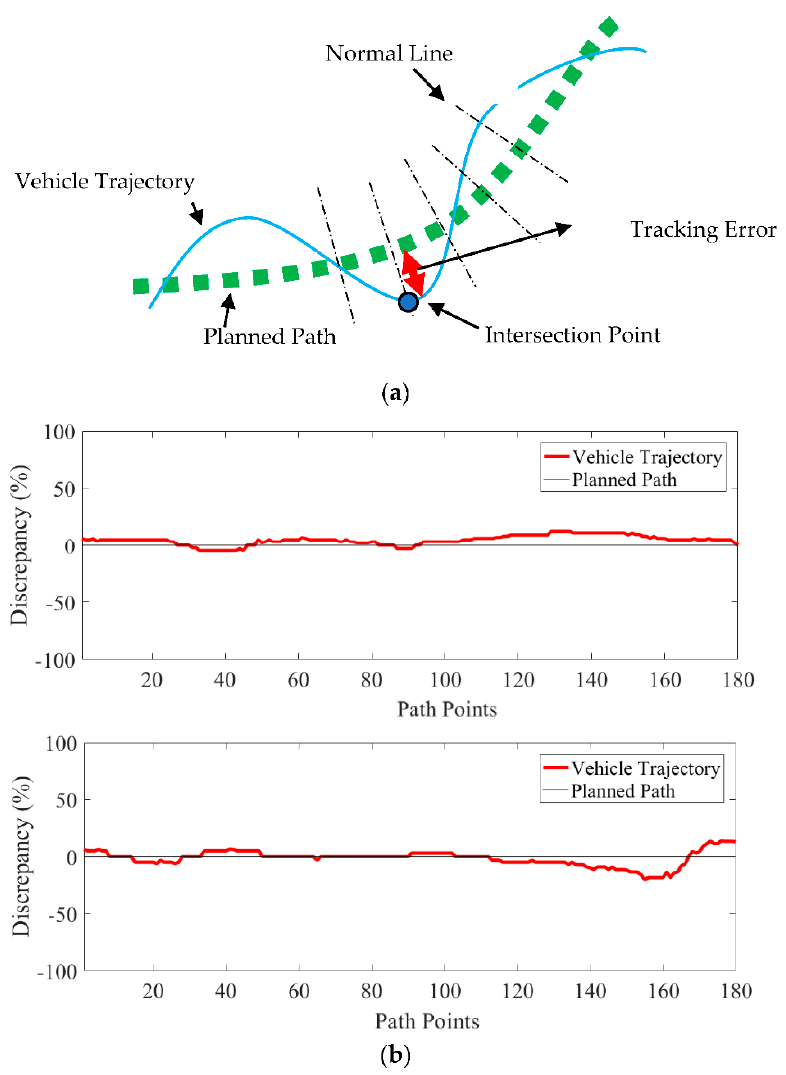
Figure 8. ( a ) Illustration of the trajectory error defined by the distance between the path point and the vehicle’s trajectory point in the experiment, and ( b ) the tracking error in the obstacle 1 environment (above) and the obstacle 2 environment (below).